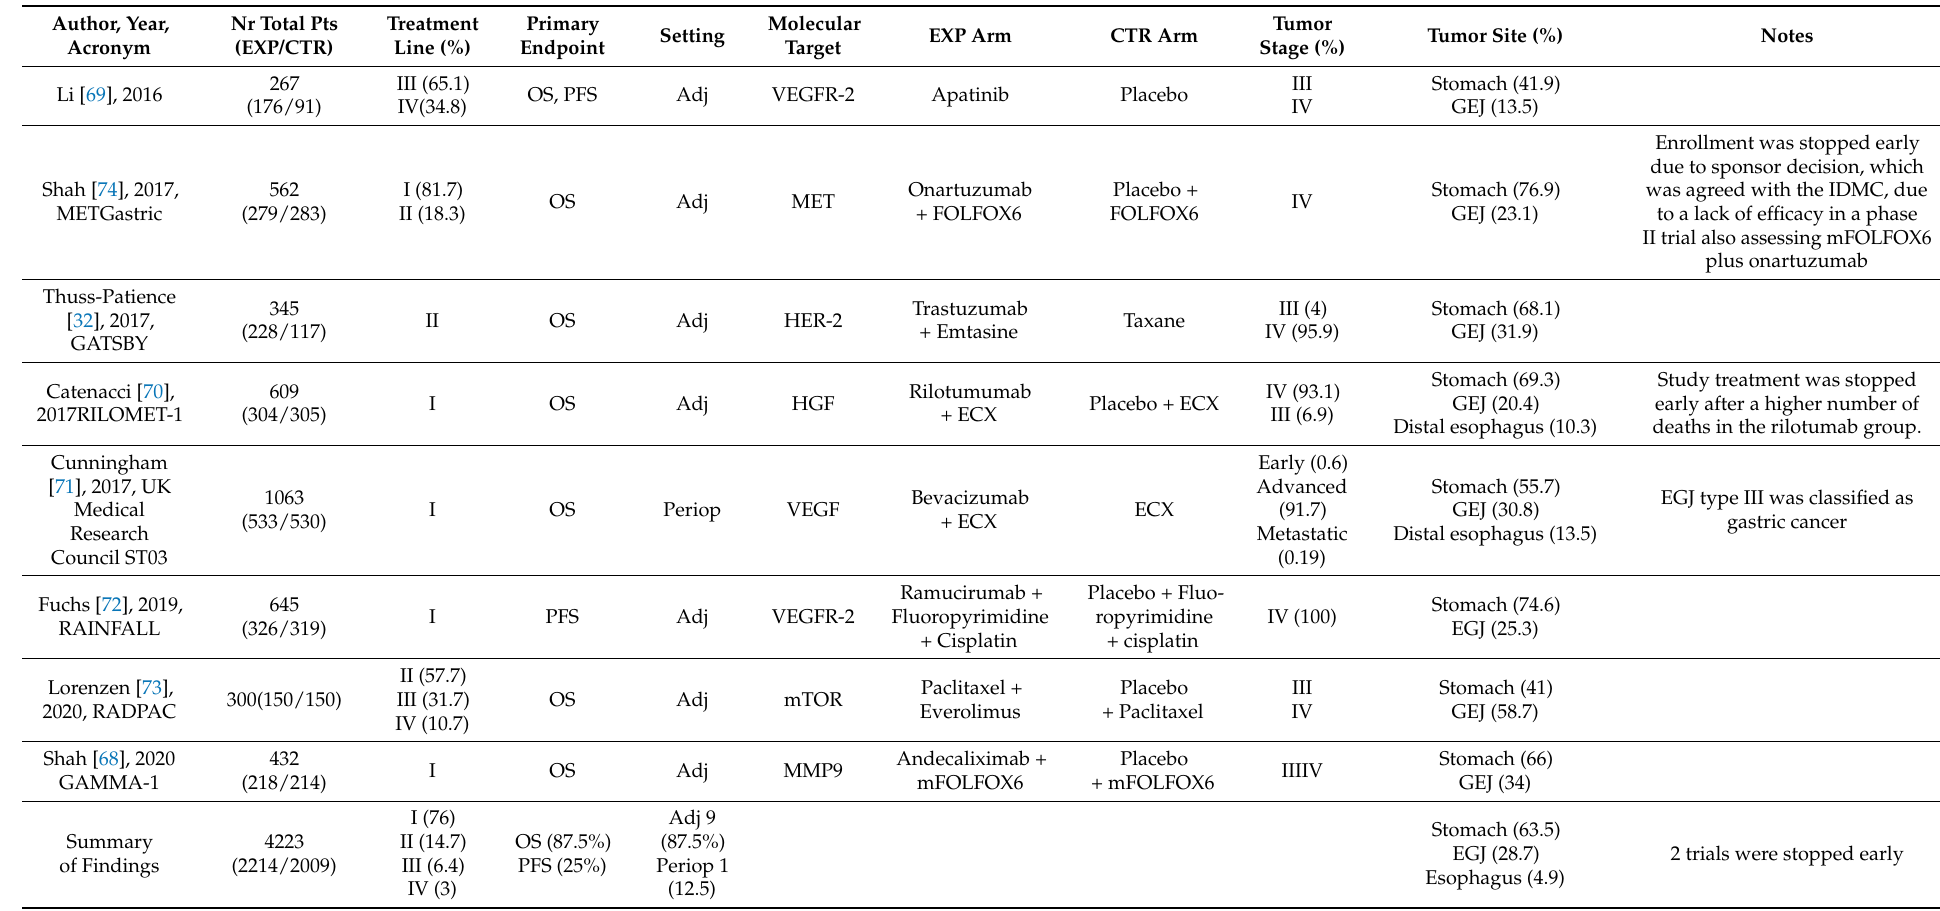
Table 2. Patient characteristics of the included studies (overall